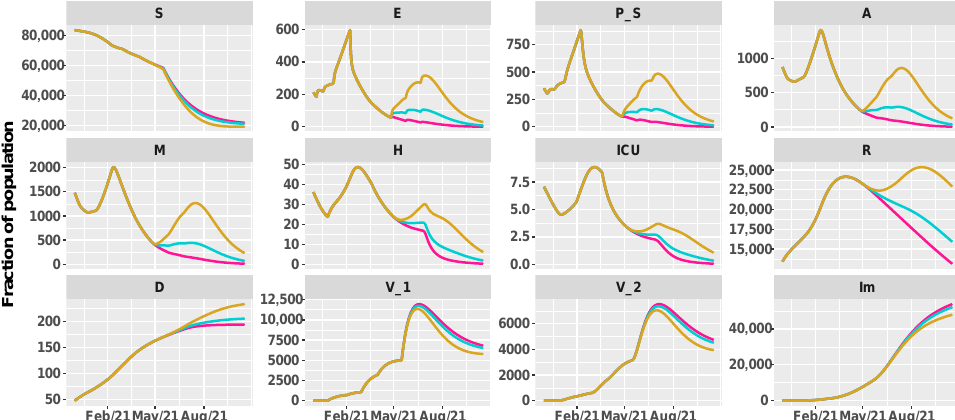
Figure 6. Projections of the epidemic evolution with a vaccination schedule of 12,500 first doses of vaccines per day in Umbria (medium vaccination). Each line corresponds to a different reopening strategy, i.e., different values of transmission rate parameters b e and b 0 (yellow for high values, blue for medium values, and pink for low